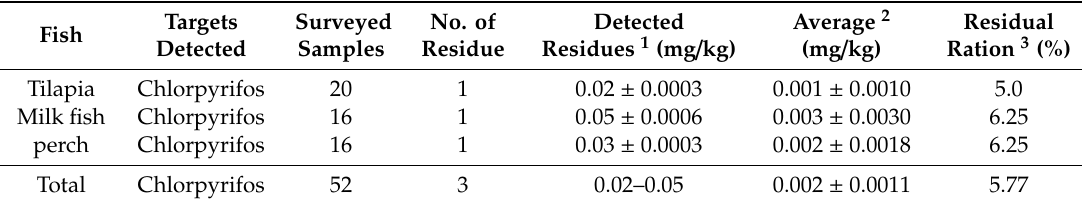
Table 2. Detected levels of residues of organophosphorus insecticides in fish samples obtained over June 2018 to October 2019.